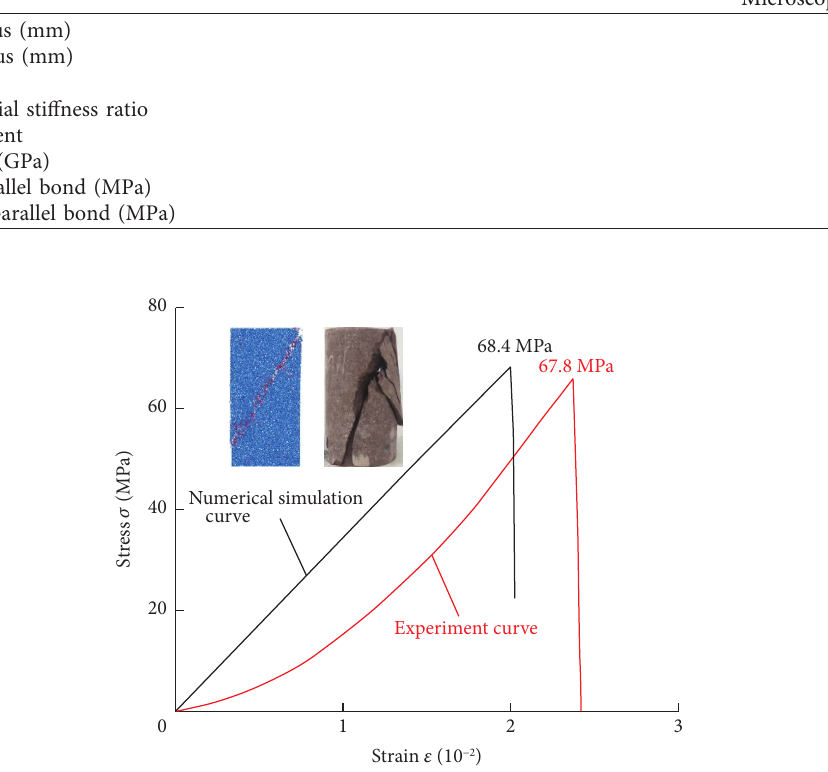
Figure 16: Comparison between numerical simulation and experimental stress-strain